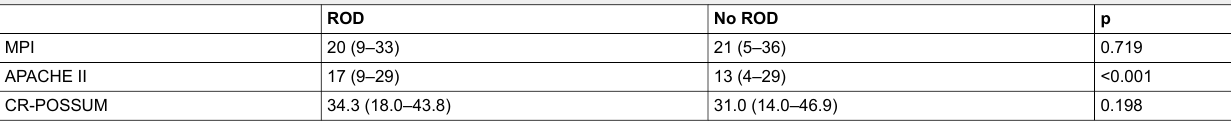
Table 3: Patients with relaparotomies on demand (ROD) had a significantly higher APACHE II score than patients without ROD. ROD